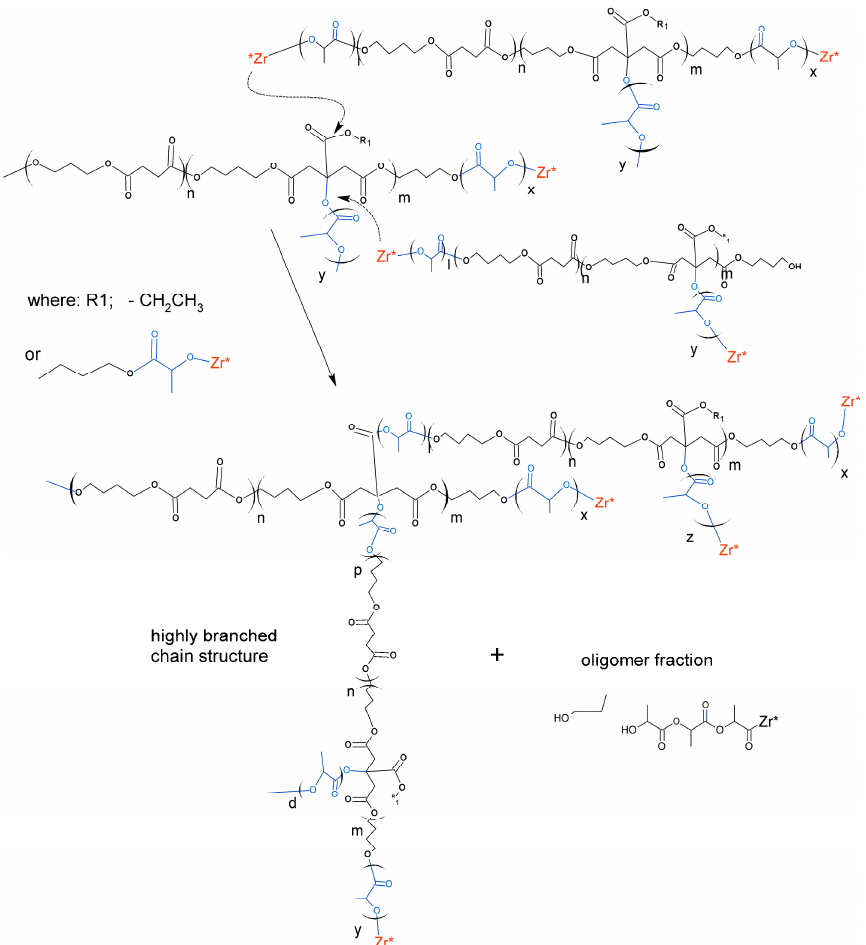
Scheme 3. The course of intermolecular transesterification process causing the formation of chain branching